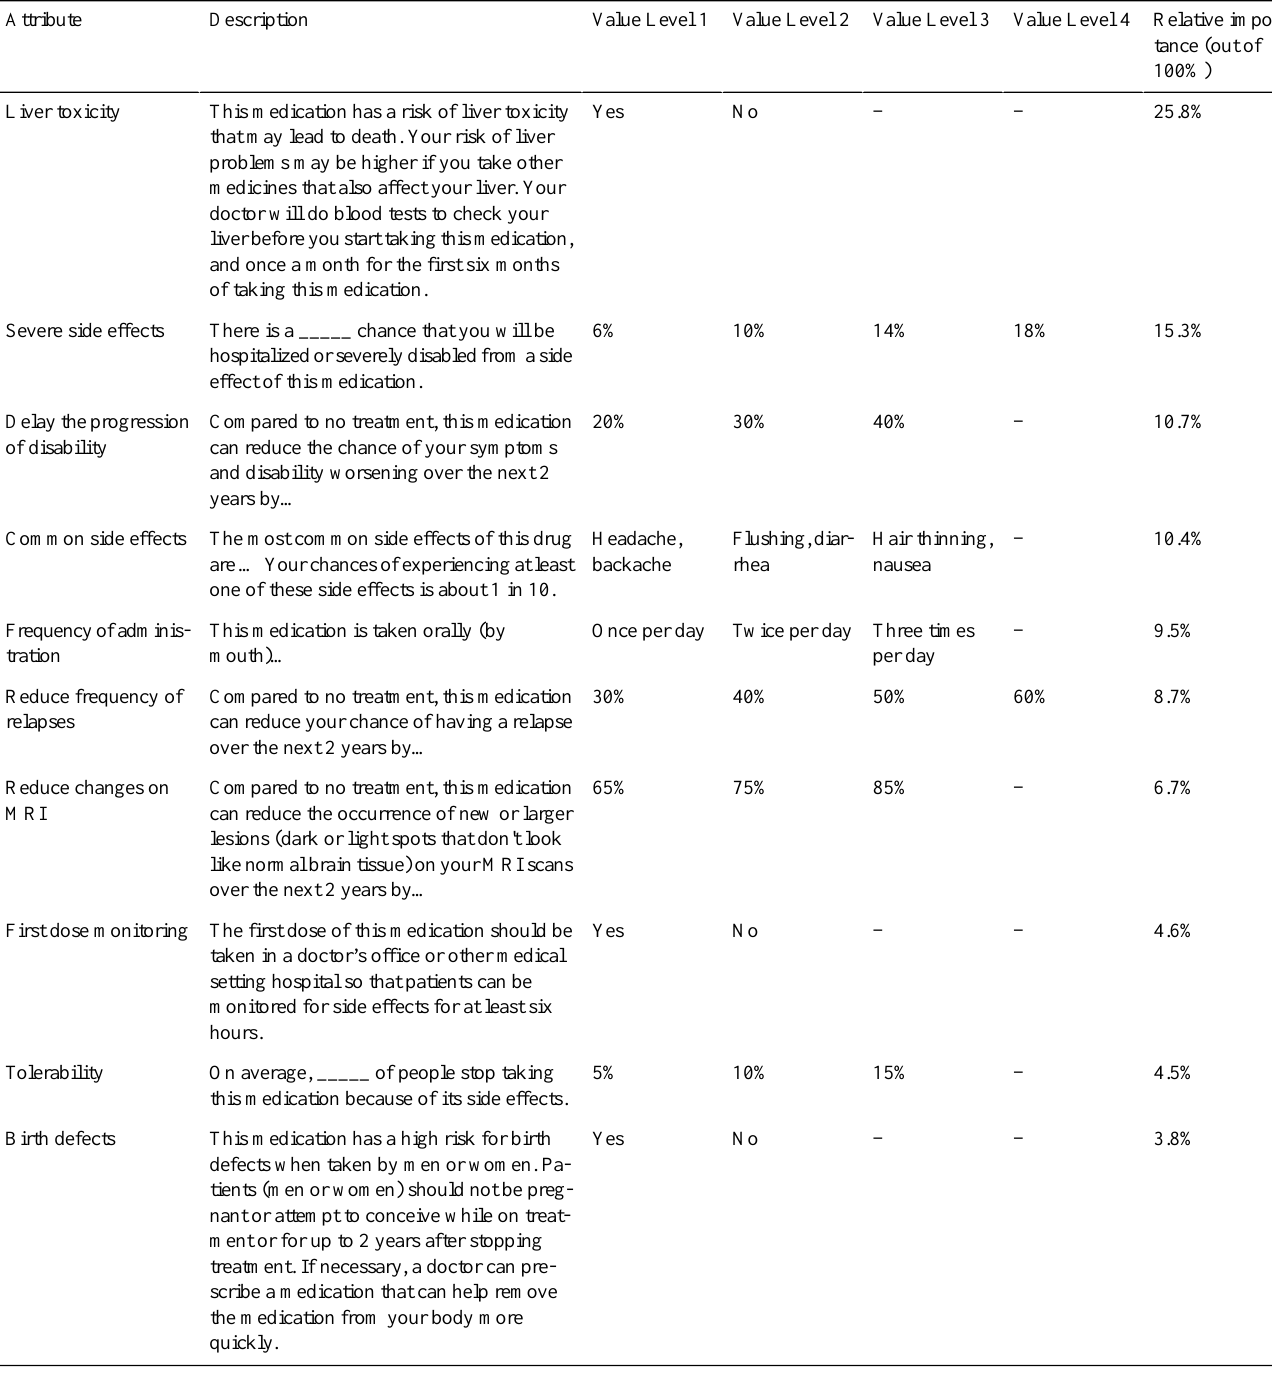
Table 1. Parameters and values for Conjoint Analysis Exercise 1 (CA1) ranked by order of importance to oral-naïve MS patients (n=319).